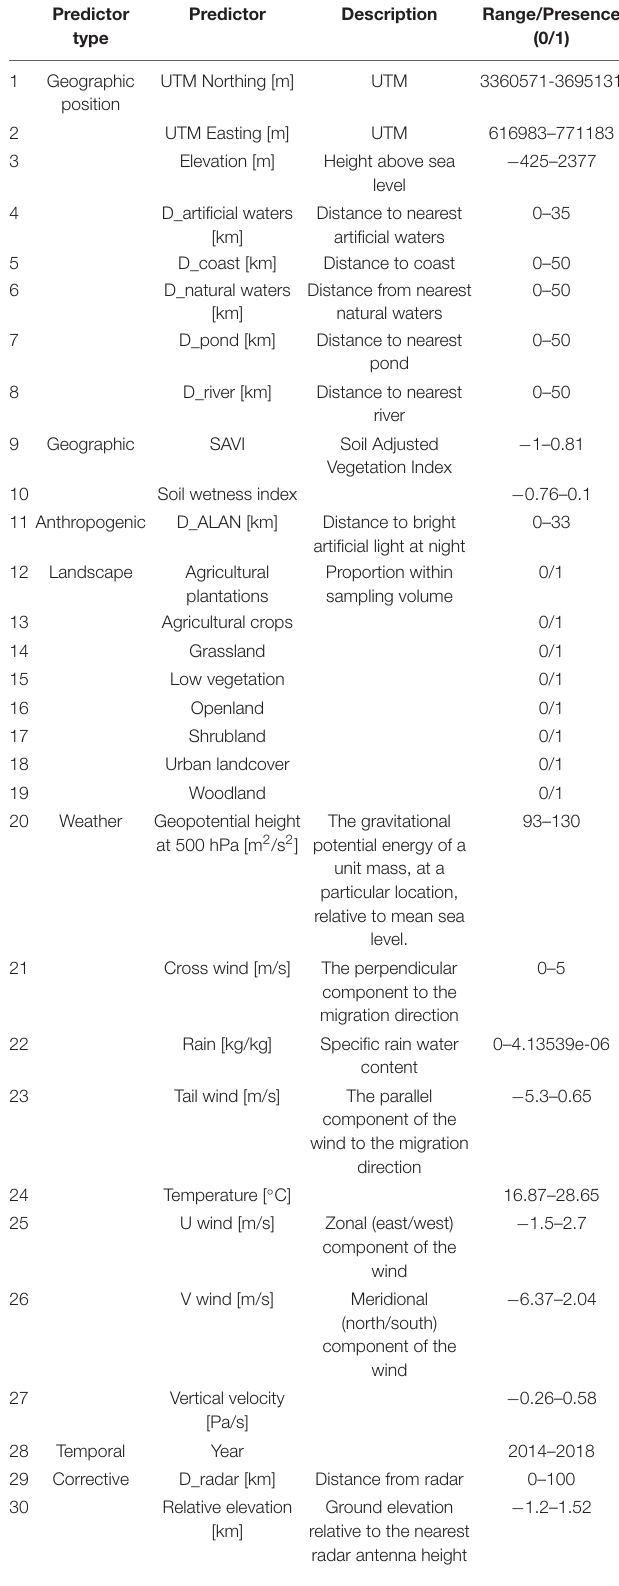
TABLE 1 | Overview of predictor variables selected to explain estimates of stopover